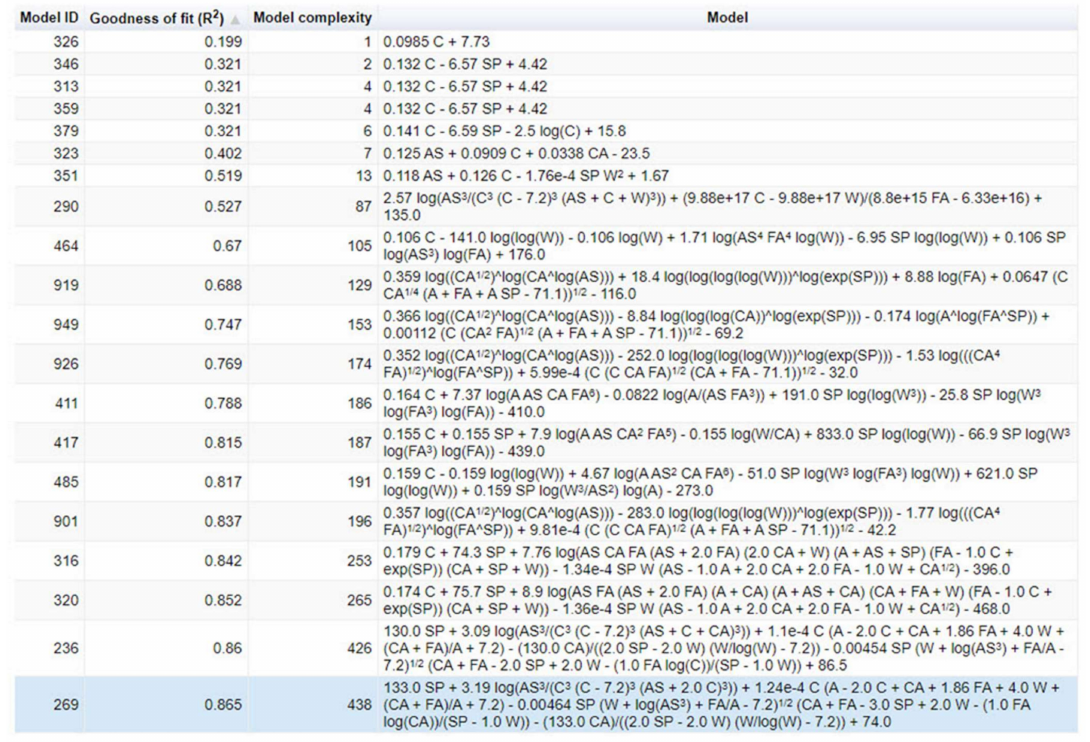
Figure A2. MGGP models that form the Pareto